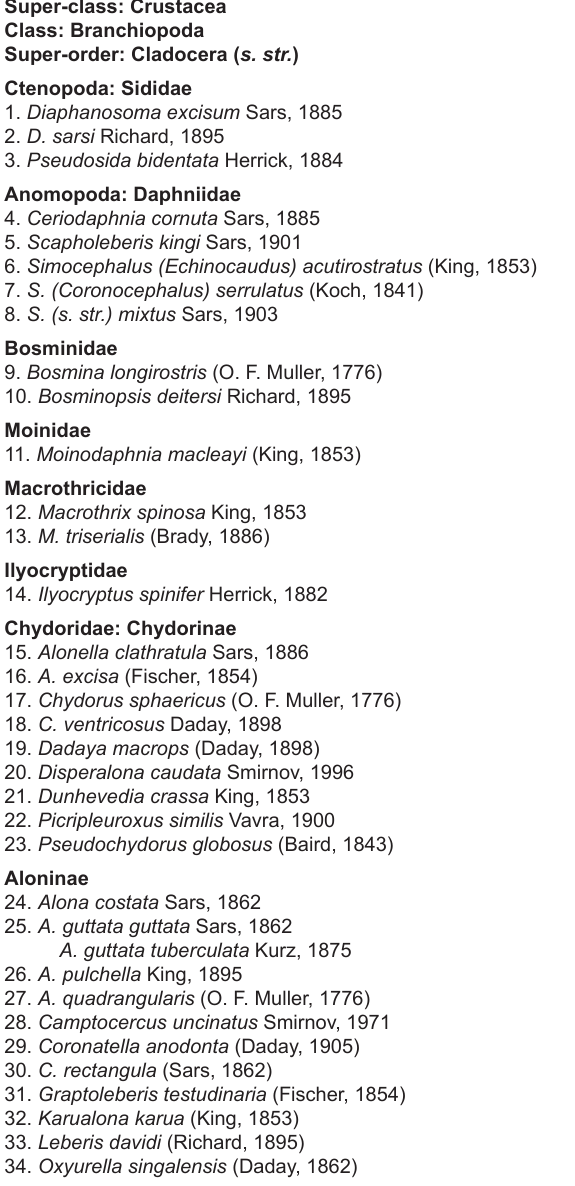
Table 2. Systematic list of the examined Cladocera